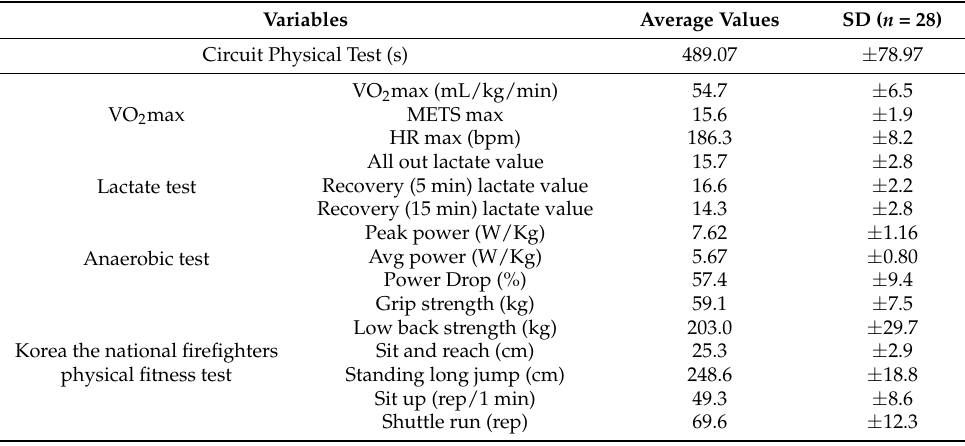
Table 4. Modified job related performance test measurement